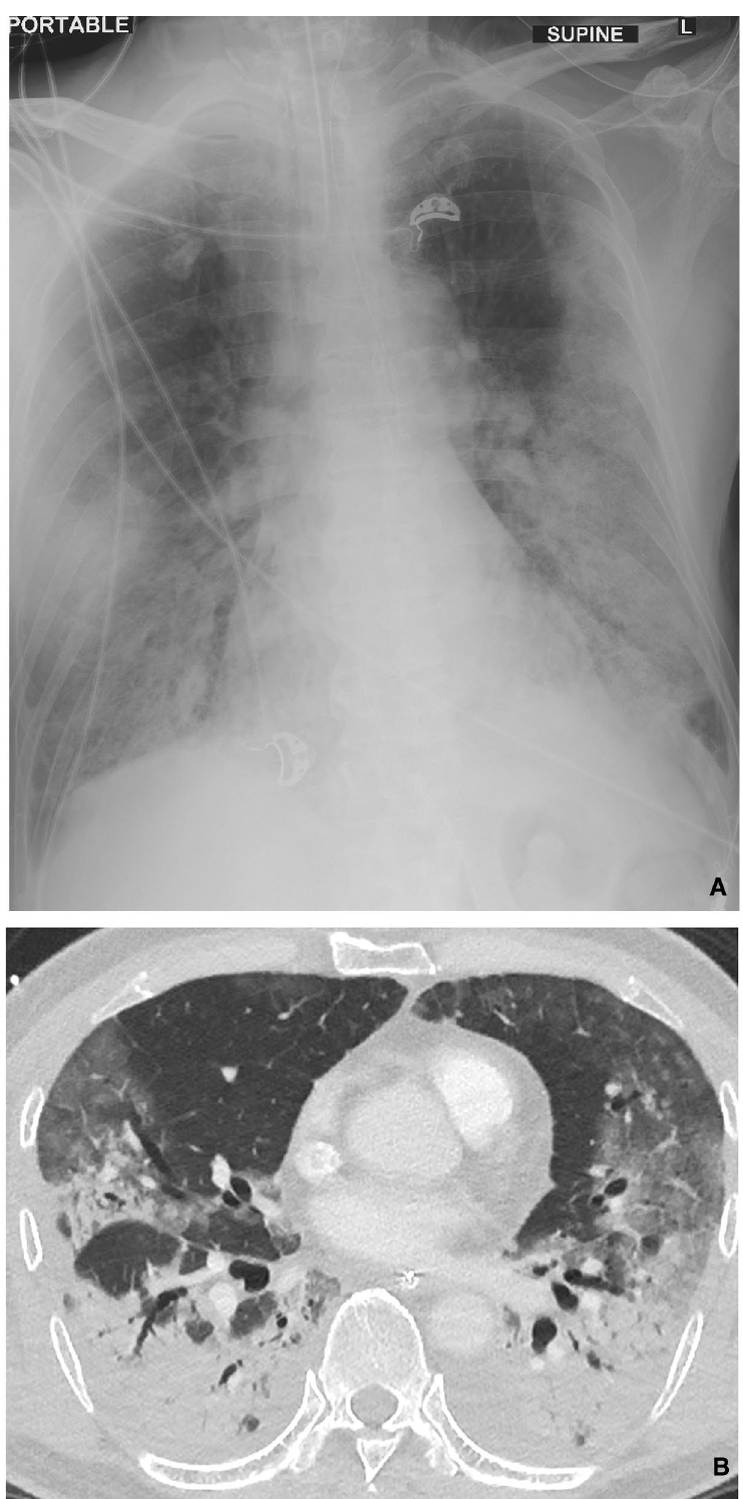
Figure 4. ( a ) Portable supine CXR shows intubated patient with mixed ground glass opacification and consolidation in the peripheries of the middle and lower zones. There is relative sparing of the central and upper zones. There is no associated pleural effusion. ( b ) Axial high resolution reconstructed CECT image across the middle zone of the lungs shows extensive bilateral lung disease with relative sparing of the anterior lobar segments. Consolidation is most notable in the superior segments of the lower lobes with smaller foci in the posterior segment of the right upper lobe. There are ground glass opacities in the lateral regions, distinct from the non-diseased medial portions of the right upper and left lingular